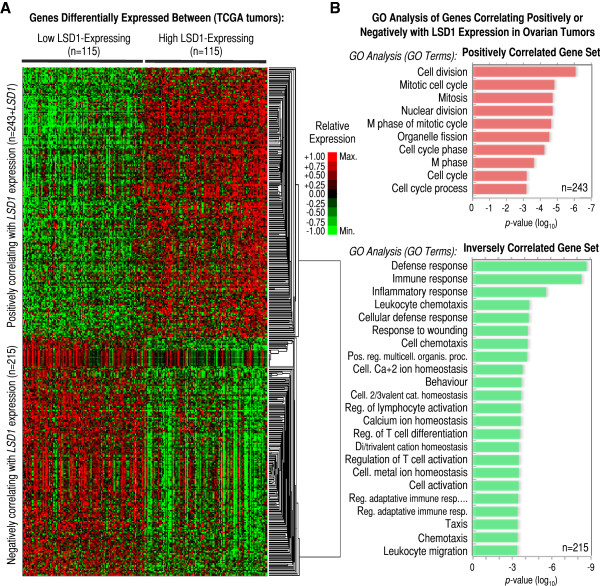
Differential expression of genes involved in cell cycle and the immune/inflammatory response associated with LSD1 mRNA overexpression in the TCGA ovarian cohort. (A) Heatmap showing hierarchical gene clustering analysis of expression profiles for n = 243 genes positively and n = 215 genes negatively correlating with LSD1 mRNA expression in n = 115 low and n = 115 high LSD1-expressing ovarian tumors (source: TCGA). Genes positively correlating with LSD1 are in the top-half section of the heatmap, while genes negatively correlation with LSD1 at the bottom-half section after clustering. Genes in this analysis were included based on: 1) showing differential expression (fold-change) >1.5 for overexpressed or <1/1.5 for underexpressed genes between the two sets of high and low LSD1-expressing tumors; 2) reaching a Delta = 3 in the comparison between both tumors sets by SAM analysis, which corresponds to FDR = 3e-05; and, 3) correlating with LSD1 expression in at least 50% tumors (both directions). The values of expression for each gene were independently normalized between the maximum (+1, or bright red) and the minimum expression levels detected (−1, or bright green) for the same particular gene (see legend), which does not allow absolute (but only relative) quantitative comparisons among genes. Therefore, overexpression is shown in red and underexpression in green. (B) List of most-enriched gene ontology (GO) terms in the set of n = 243 genes positively (top panel, red) and n = 215 genes negatively or inversely (bottom panel, green) correlating with the pattern of LSD1 mRNA expression. GO terms shown in the left. The x-axis refers to p-value of enrichment.